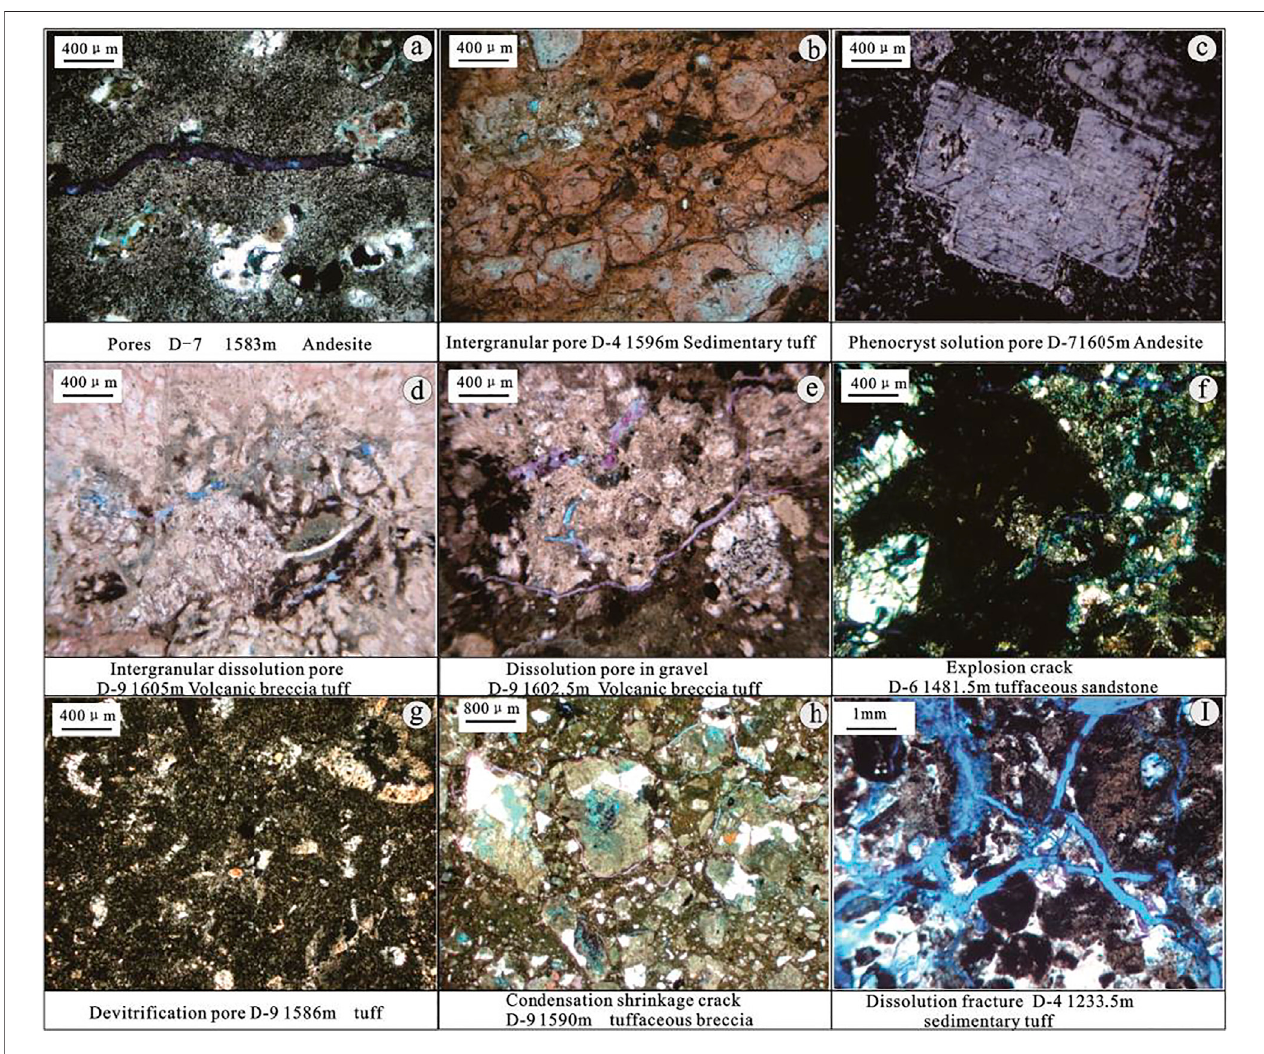
FIGURE 7 | Photos of the Mesozoic volcanic reservoir space types in the D oil fi eld of the Laizhouwan sag.